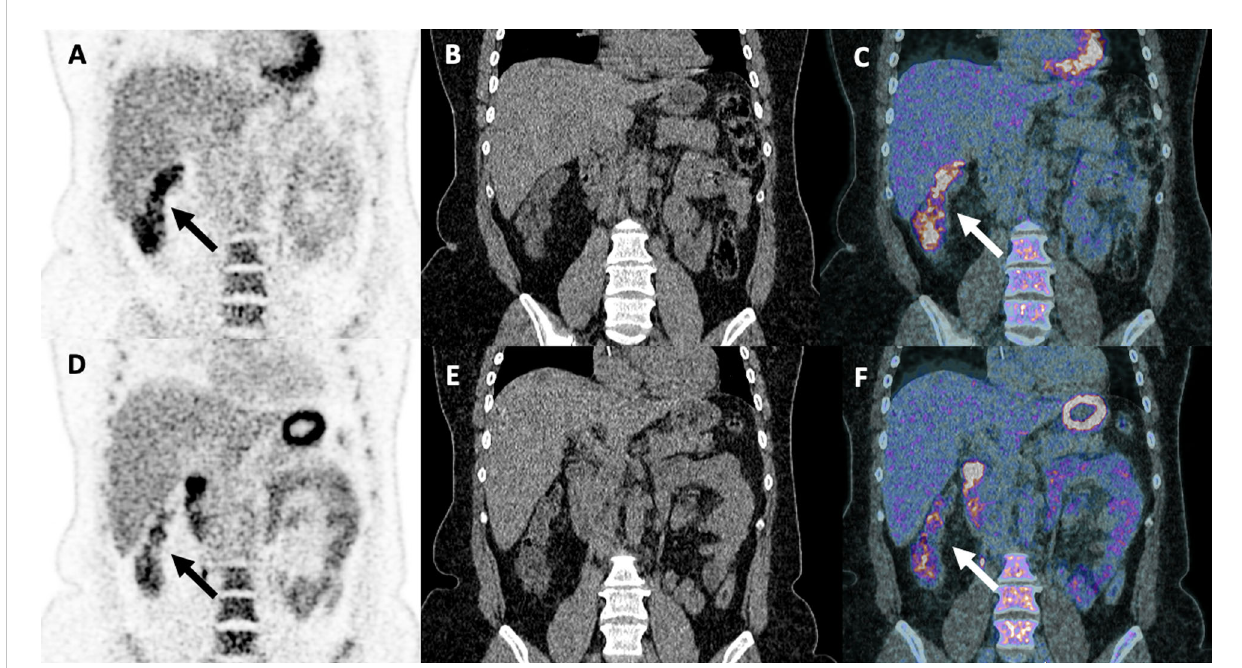
FIGURE 1 Partial pathological uptake of the right colon suspecting early signs of colitis in a 48-year-old woman with stage IV melanoma treated with two cycles of ipilimumab (anti-CTLA-4) and nivolumab (anti-PD-1). Treatment was discontinued due to grade II colitis diagnosed 3 weeks after the fi rst 18 F-FDG PET/CT scan [arrows; coronal PET (A) , CT (B) and merged PET/CT (C) images], which required high-dose steroid treatment for 3 months. A decreased right colon uptake was observed on follow-up 18 F-FDG PET/CT examination performed 4 weeks after the introduction of steroid treatment [arrows; coronal PET (D) , CT (E) and fused PET/CT images (F)